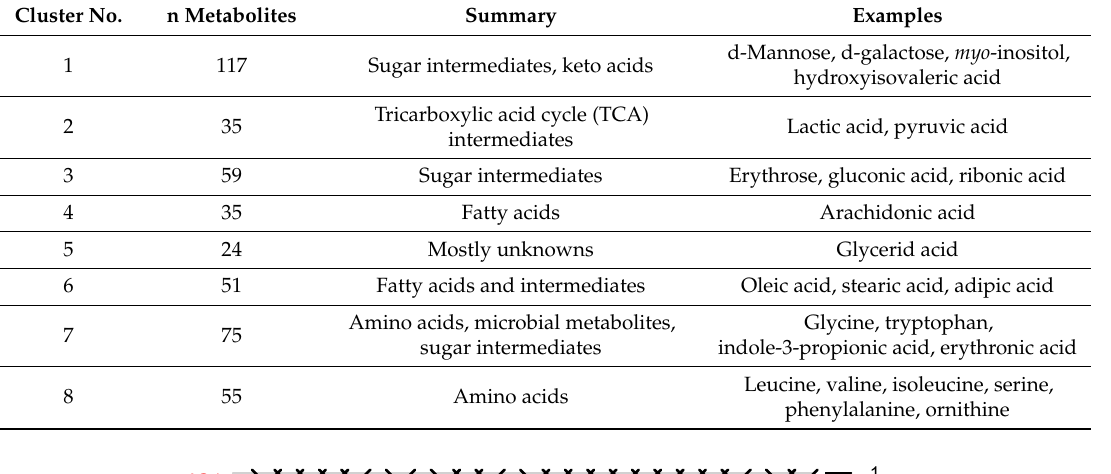
Table 2. Summary of metabolite clusters.